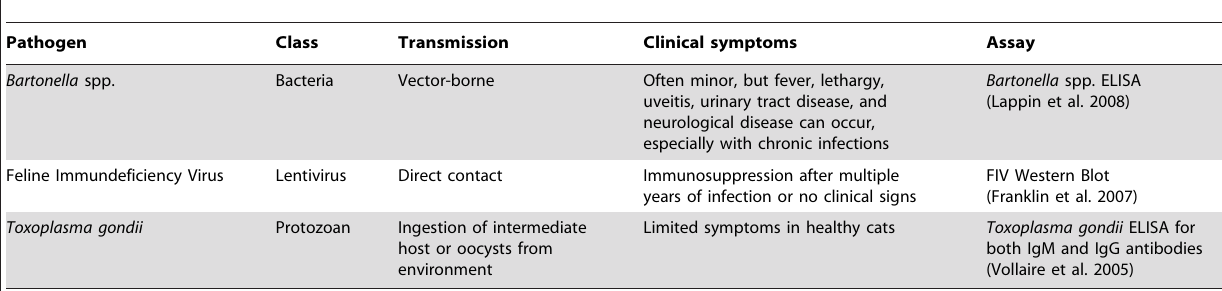
Table 1. Comparison of the three pathogens under